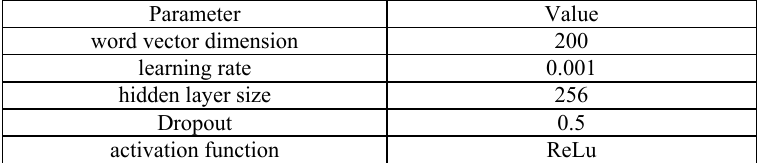
Table 3. LSTM network parameters.